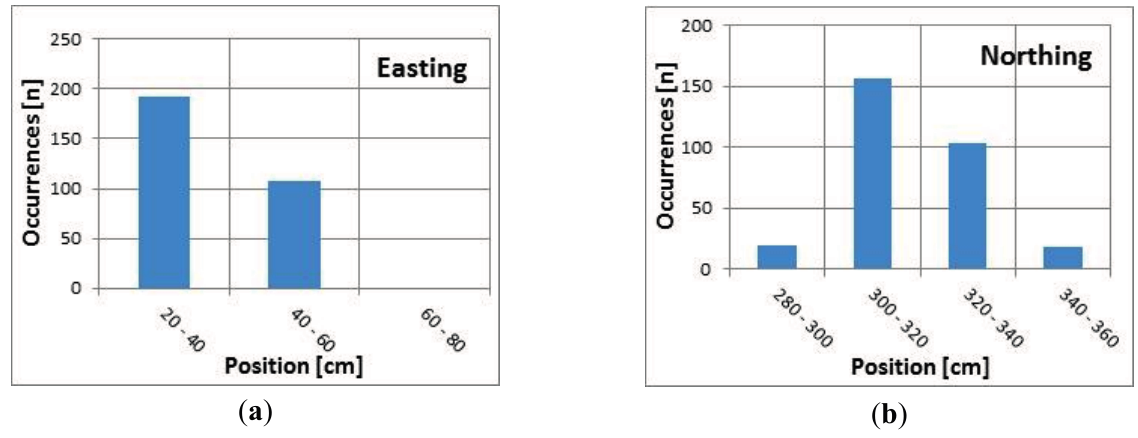
Figure 7. DGNSS easting ( a ) and northing ( b ) distribution.